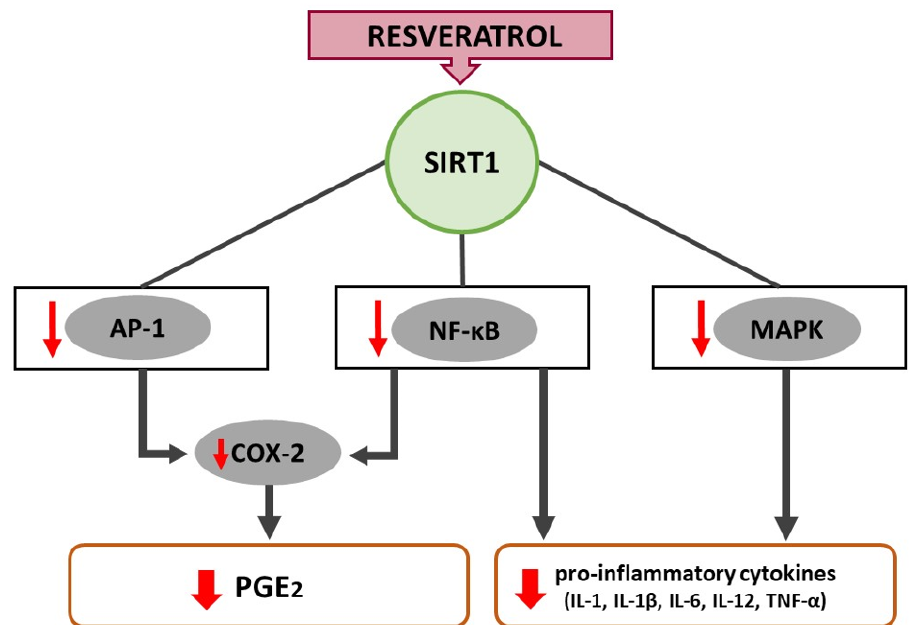
Figure 2. Resveratrol-induced signal transduction leading to an attenuated inflammatory response through downregulation of AP-1, NF-κB and MAPK.